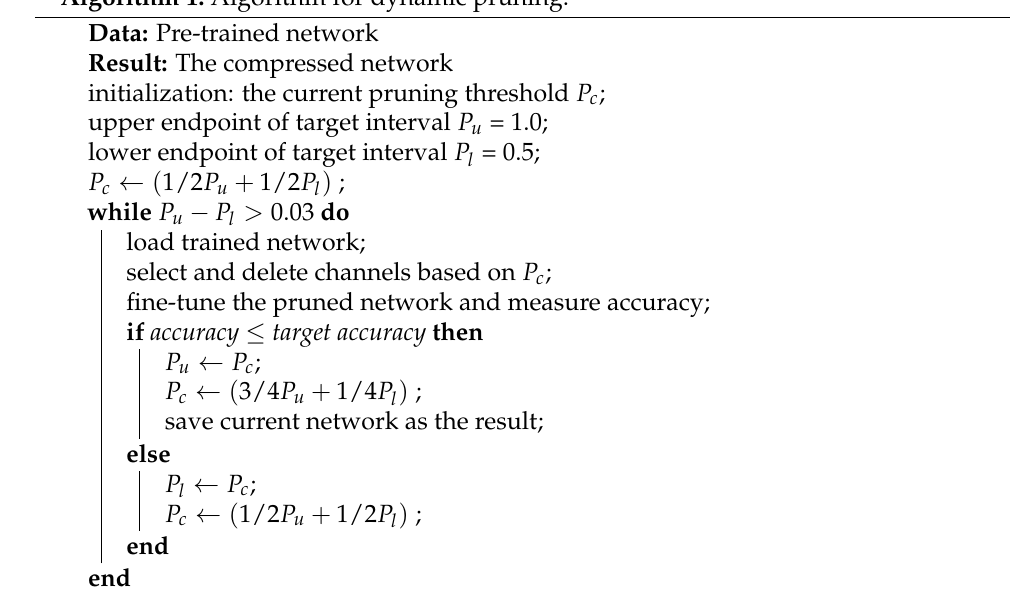
Algorithm 1: Algorithm for dynamic pruning. Data: Pre-trained